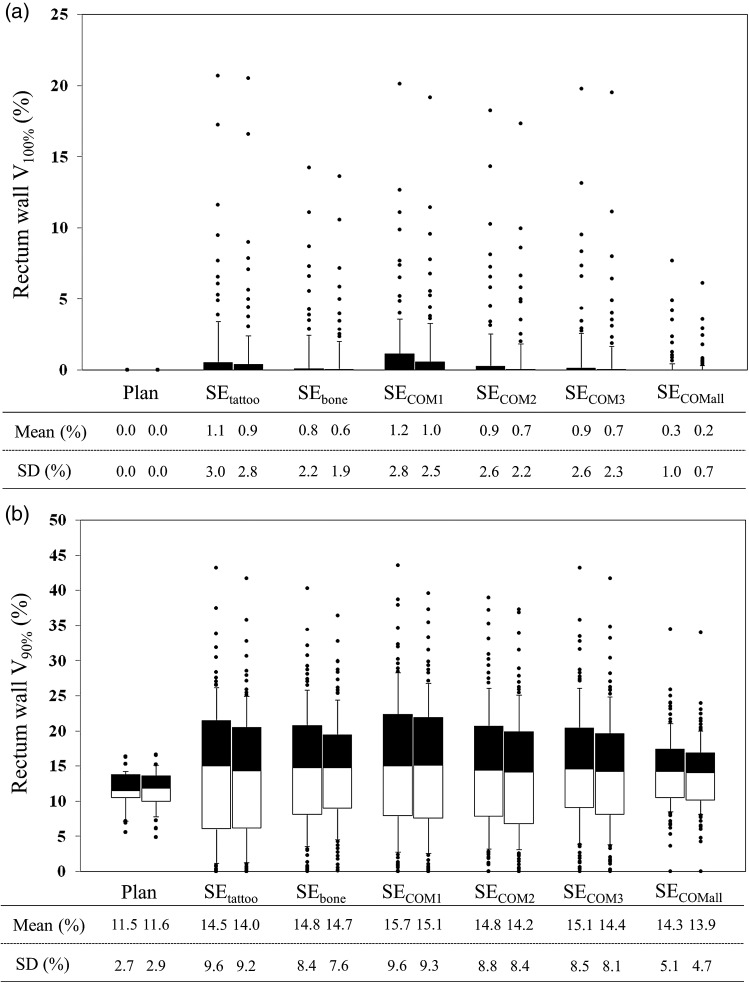
Interfractional change in rectum wall (a) V100% and (b) V90%. For each set-up correction policy, the left and right box plots show data in the PTV8/5 and PTV5/5 groups, respectively. Dose analysis parameters are graphically presented in box plots (showing medians, and 25th and 75th percentiles) with whiskers (10th and 90th percentiles); outliers are shown as dots.